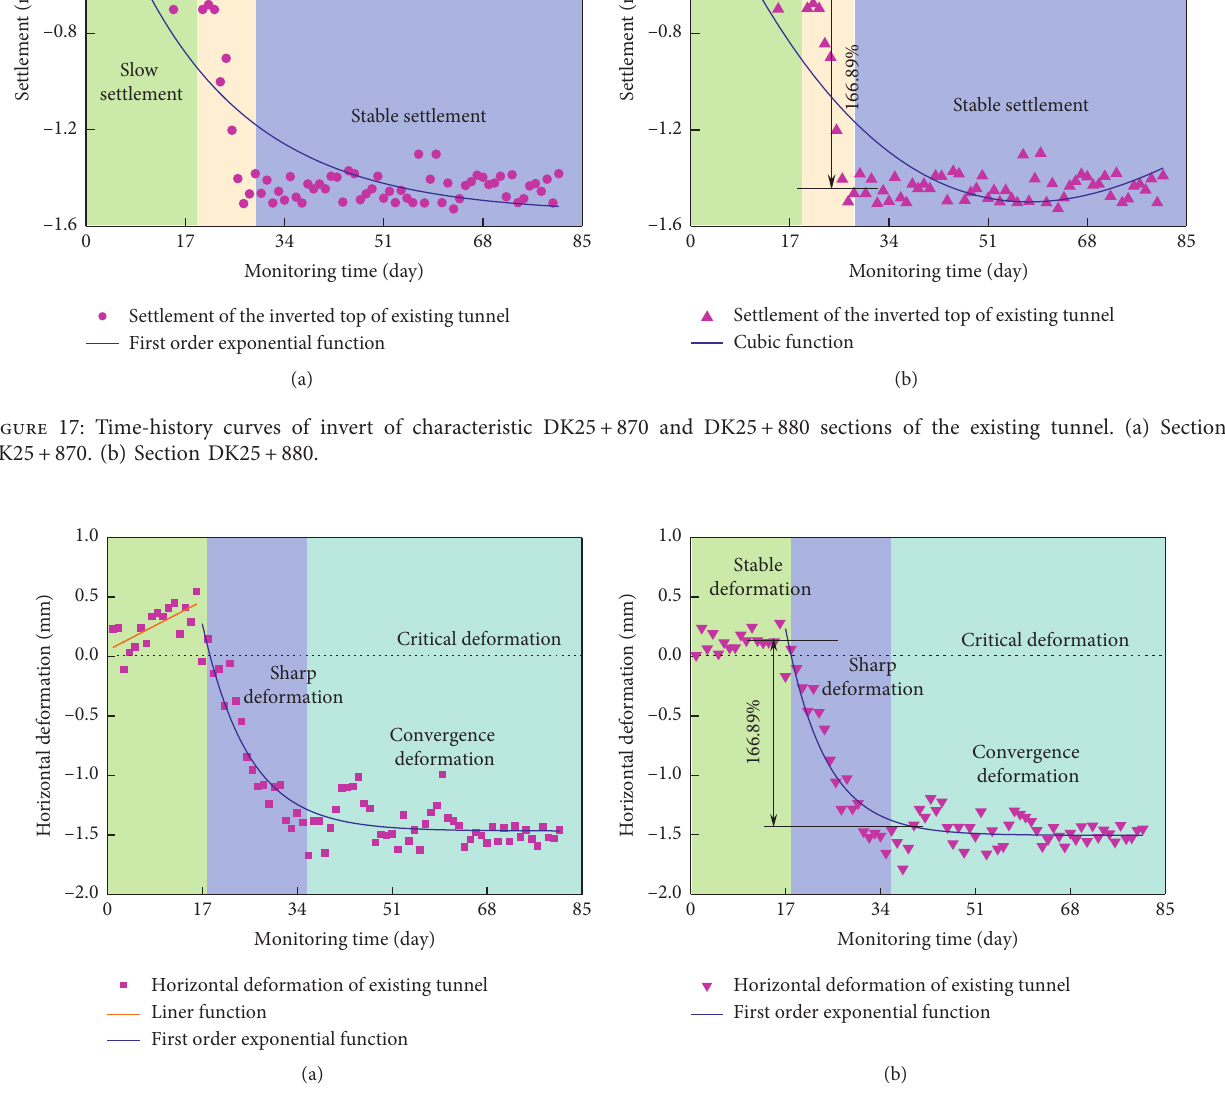
Figure 18: Time-history curves of horizontal deformation in characteristics sections of the existing tunnel. (a) DK25+ 870 section. (b) DK25 +880